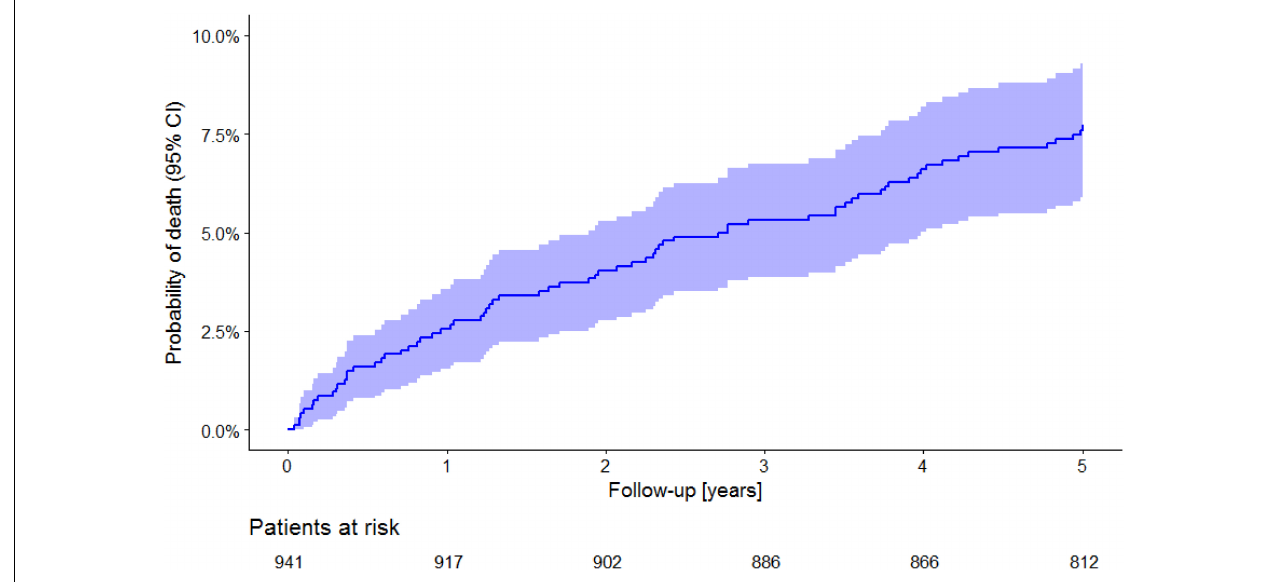
FIGURE 1 | All-cause mortality in the study population. The Kaplan–Meier curve of probability of death is shown together with its 95% confidence intervals. Numbers of patients at risk are shown below the time axis.